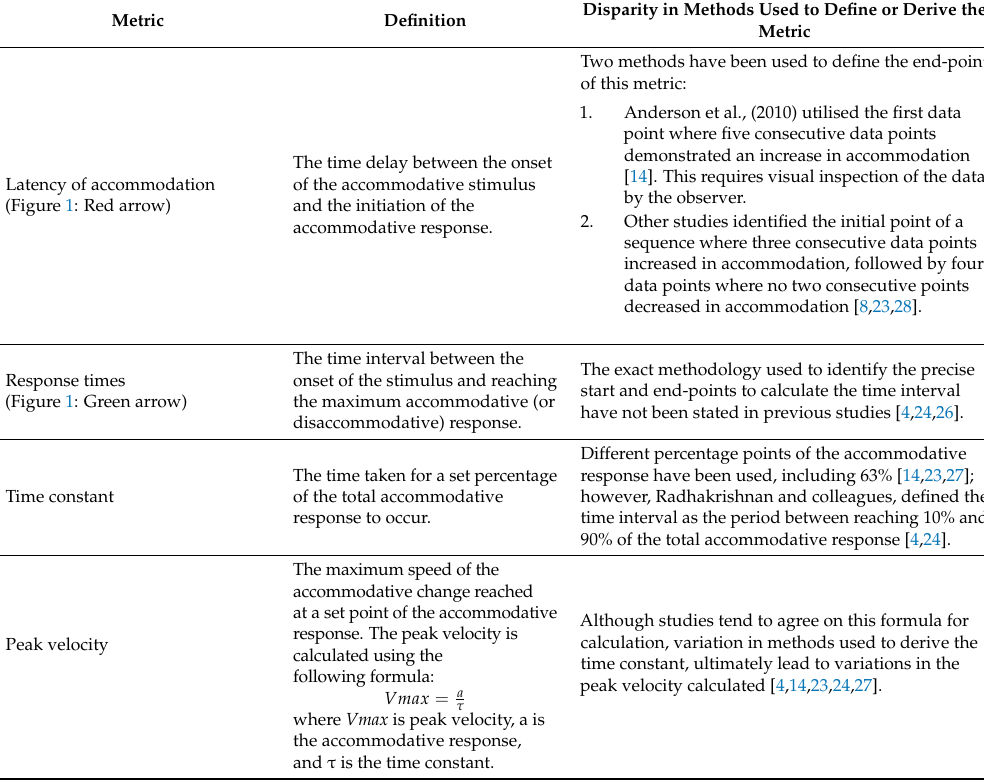
Latency of accommodation (Figure 1: Red arrow)